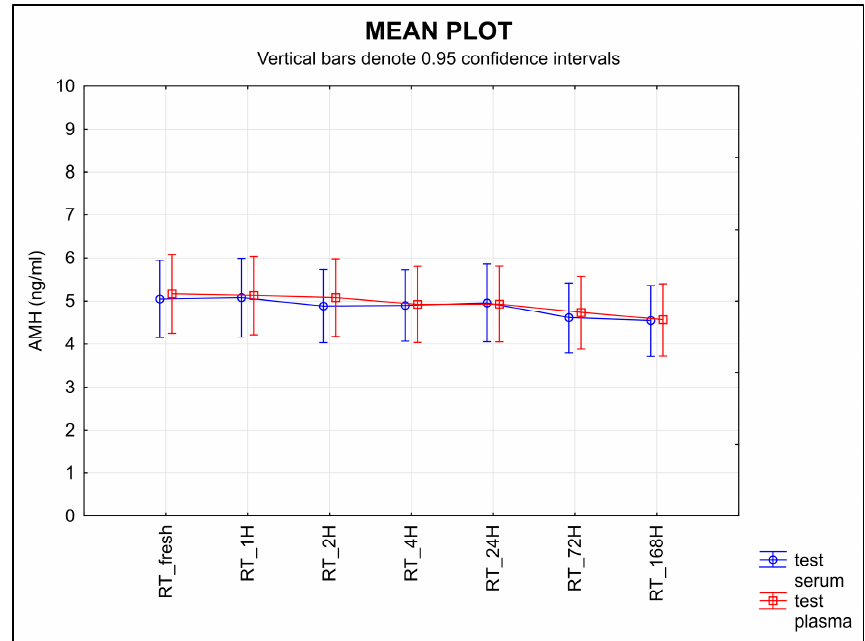
Figure 3. The stability of AMH after separation, stored at RT. Legend: The stability of AMH after separation, stored at RT, decreased for both types of samples with time. An equivalence test using a ± 0.30 ng/mL limit of tolerance failed to find equivalence for either serum or plasma samples ( p = 0.9790 for serum, p = 1.0000 for